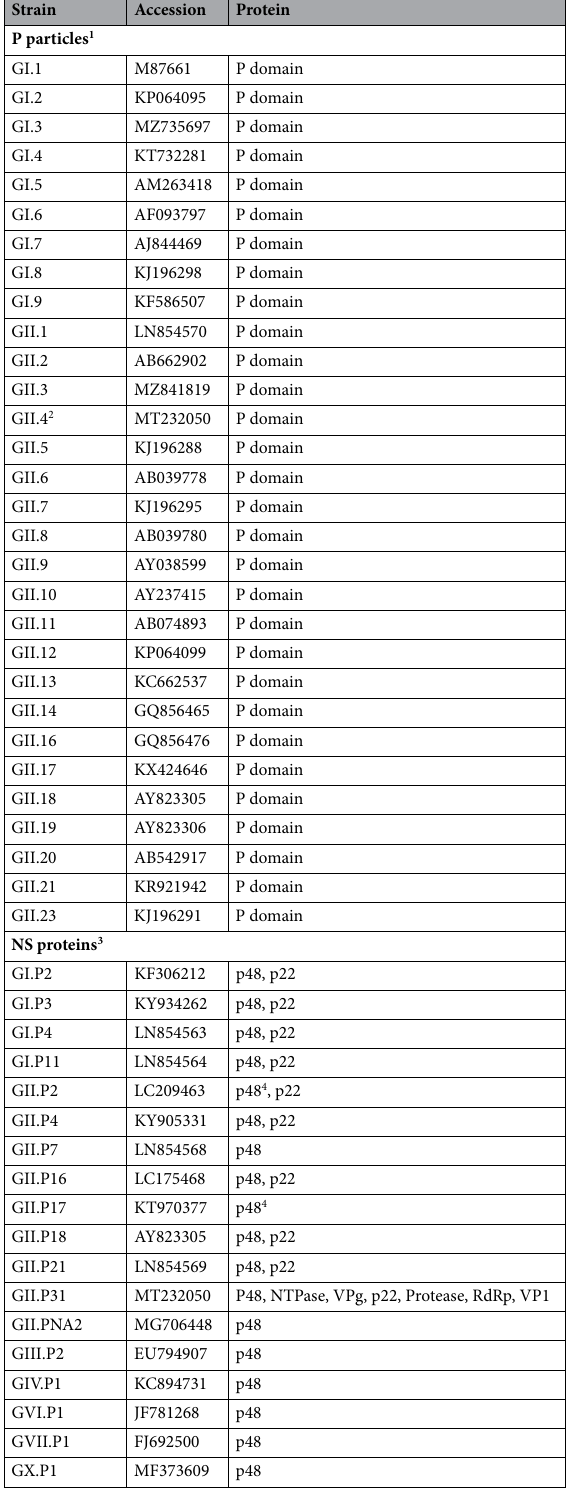
Table 4. Noroviruses used for antigen production. 1 Restriction enzymes BamHI and NotI. The P domain starts at amino acid position 222 of the GII.4 Sydney reference genome (MT232050). 2 GII.4 Sydney 2012. 3 Unless mentioned otherwise, NotI/XmaI. 4